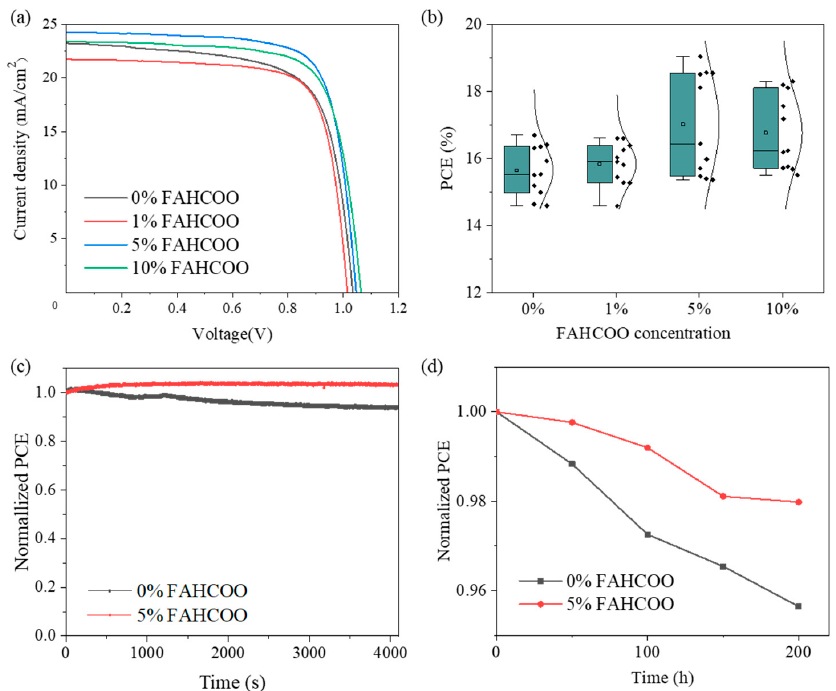
Figure 5. ( a ) Comparison of the J–V curves of the best PCE FAPbI 3 devices prepared with different dosages (0%, 1%, 5%, 10%) of FAHCOO. ( b ) Boxplots of PCE statistics of devices based on FAPbI 3 films with different doping amounts of FAHCOO. ( c ) Comparison of PCE changes between the FAPbI 3 device with the optimal amount of FAHCOO (5%) and the undoped control FAPbI 3 device in the air environment. ( d ) Normalized PCE change of the FAPbI 3 device prepared with or without FAHCOO